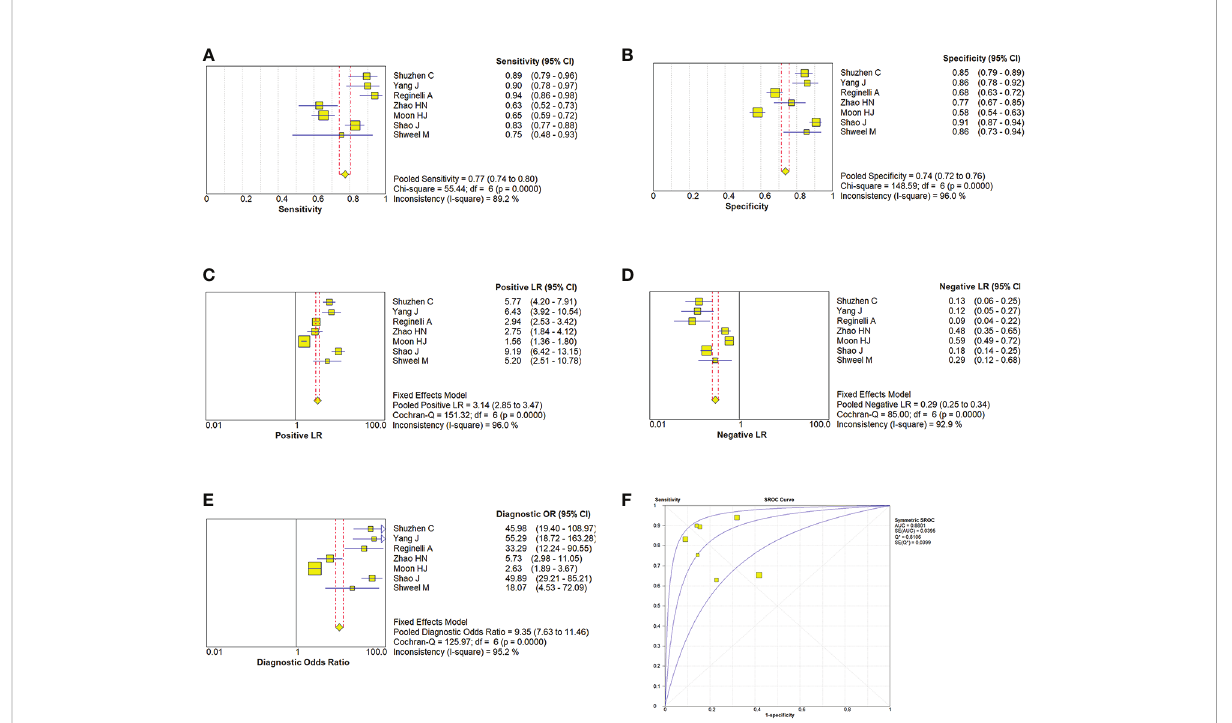
FIGURE 6 Estimates of elastosonography assessment for the diagnosis of malignancy thyroid nodules. (A – E) Forest plots illustrate pooled estimates (diamonds) for sensitivity (A) , speci fi city (B) , positive likelihood ratio (LR) (C) , negative LR (D) , and diagnostic odds ratio (E) and corresponding 95% CIs for pooled estimates. (F) Summary receiver operating characteristic (SROC) plot for assessing accuracy with corresponding curves indicative of upper and lower bounds of 95% CI. AUC = area under curve, SE = standard error, Q* = summary measure of accuracy derived from the SROC